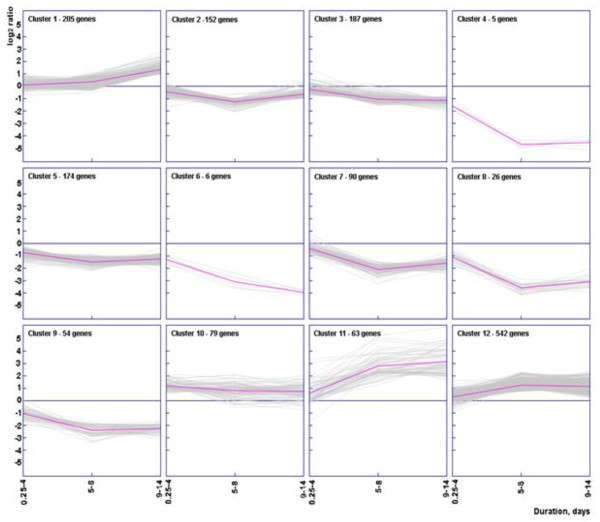
Results from K-means cluster analysis. Genes were divided into 12 clusters using a K-means cluster analysis algorithm, which distinguishes sets of genes with similar expression profiles with respect to time. Relative expression levels (log2 ratio) for each gene and the average expression values (magenta line) are shown at different time points (0.25-4d, 5-8d and 9-14d) compared to control conditions.